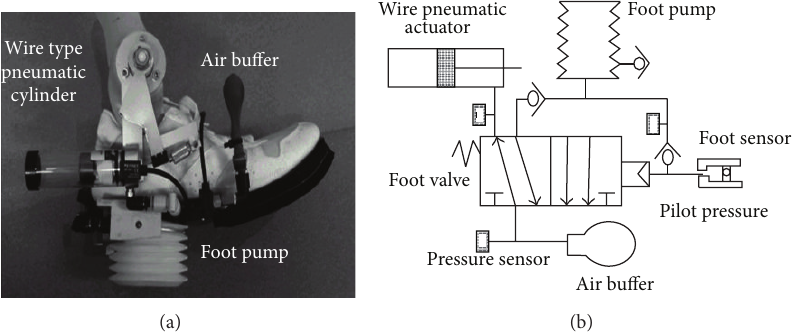
Figure 5: (a) Different components and (b) pneumatic driving circuit of a power harvesting AFO [39].